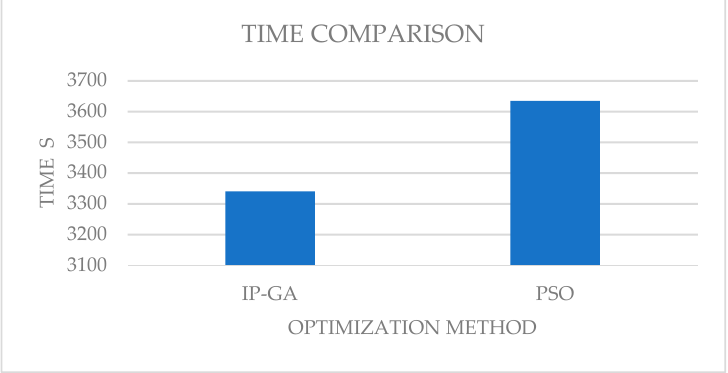
Figure 10. Runtimes for the proposed methods.